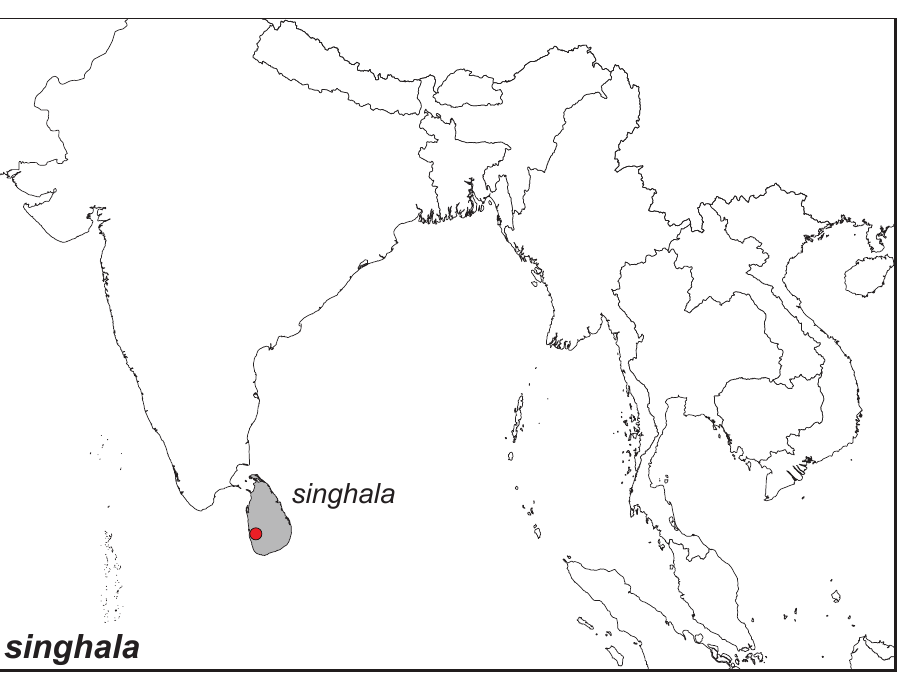
Figure 78. Distribution map of Elymnias singhala .